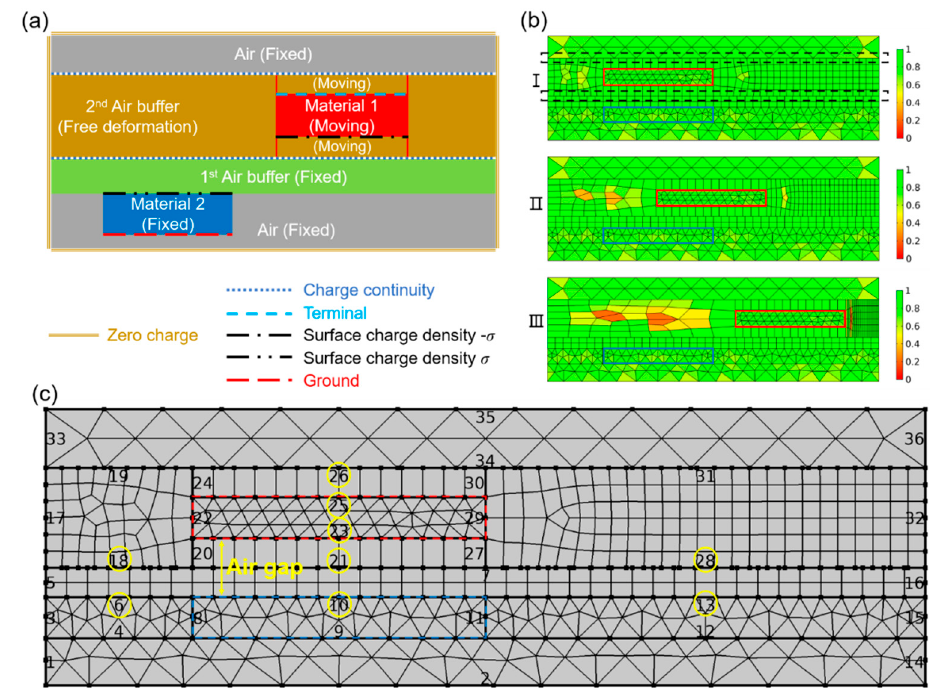
Figure 5. ( a ) Boundary conditions for sliding mode TENG. ( b ) Mesh quality deteriorates when Material 1 moving from state I to III. ( c ) The meshed geometry of sliding mode TENG.